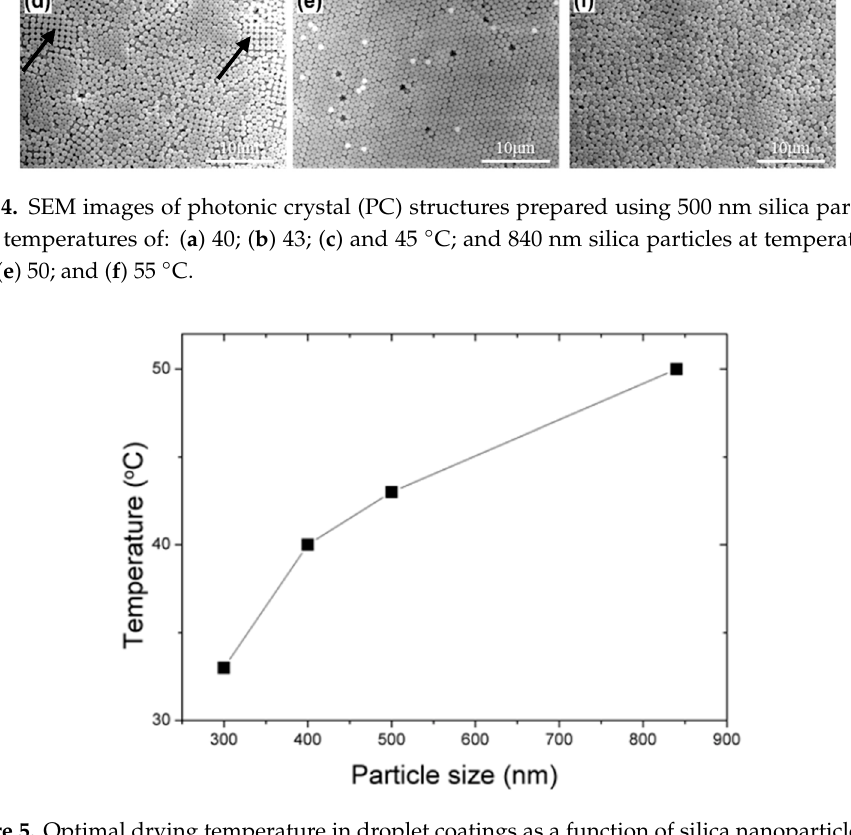
Figure 5. Optimal drying temperature in droplet coatings as a function of silica nanoparticle size.